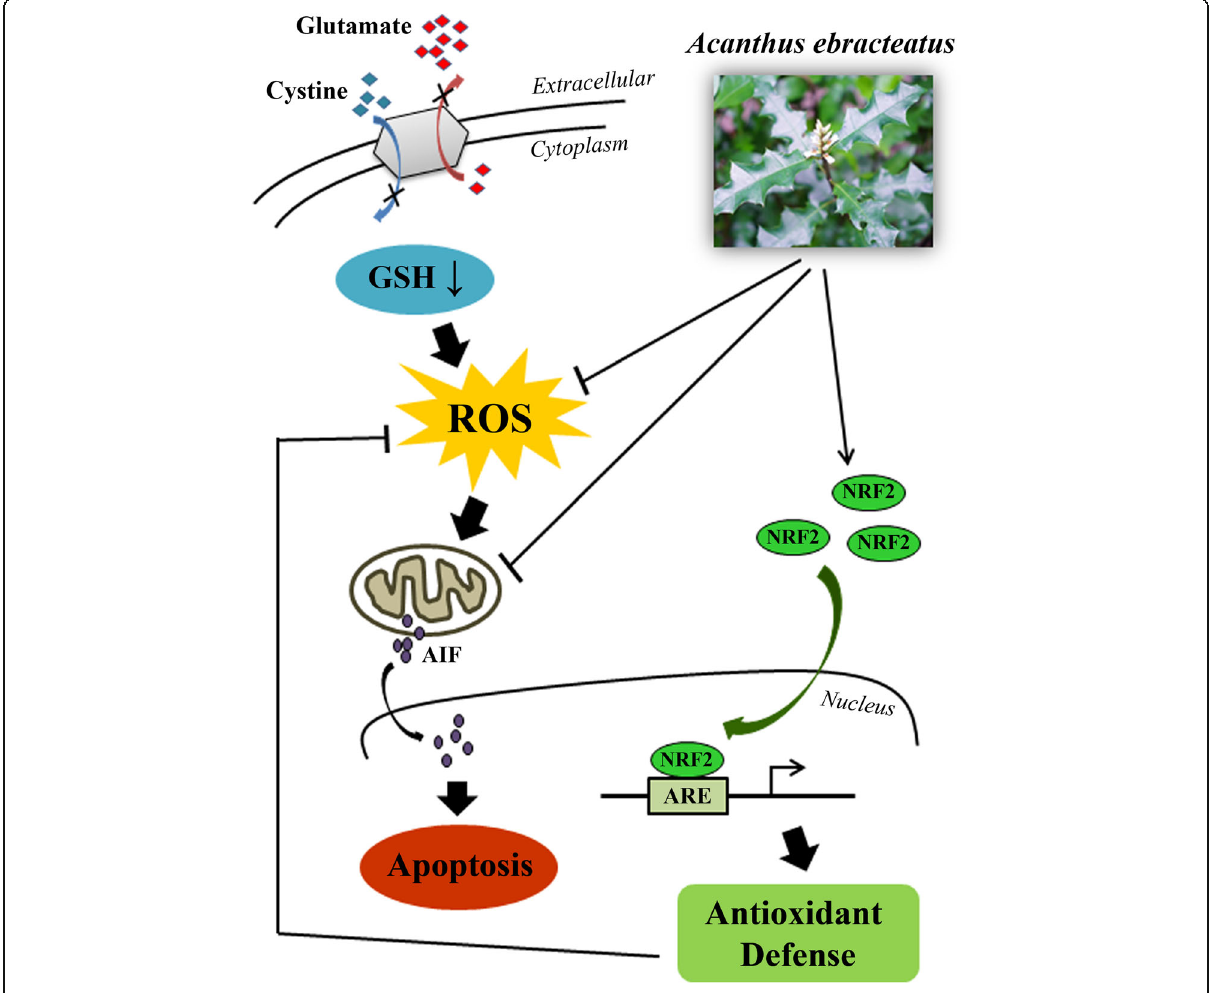
Fig. 7 Schematic diagram showing the proposed mechanism underlying neuroprotective effect of AE leaf extract against glutamate-induced oxidative toxicity. AE leaf extract provides neuronal cell protection against oxidative stress-mediated apoptosis induced by excessive extracellular glutamate by suppressing ROS formation, inhibiting AIF translocation into the nucleus, and activating the Nrf2/ARE signaling